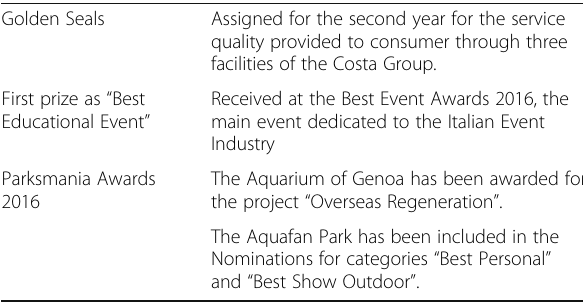
Table 7 Awards and Recognitions obtained in 2016 Golden Seals Assigned for the second year for the service quality provided to consumer through three facilities of the Costa